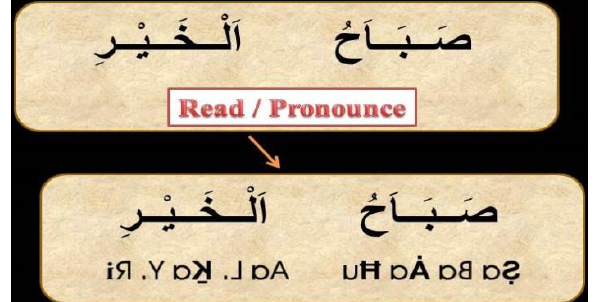
Figure 9. Pop-up Roman phonetics under Arabic script in ETaJWa